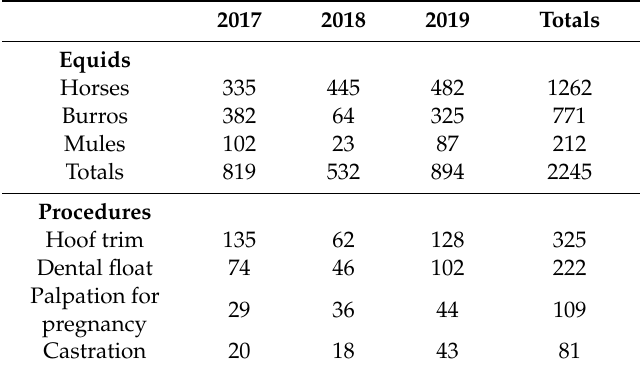
Table 2. Numbers of equids for which care was provided and procedures performed from 2017 to